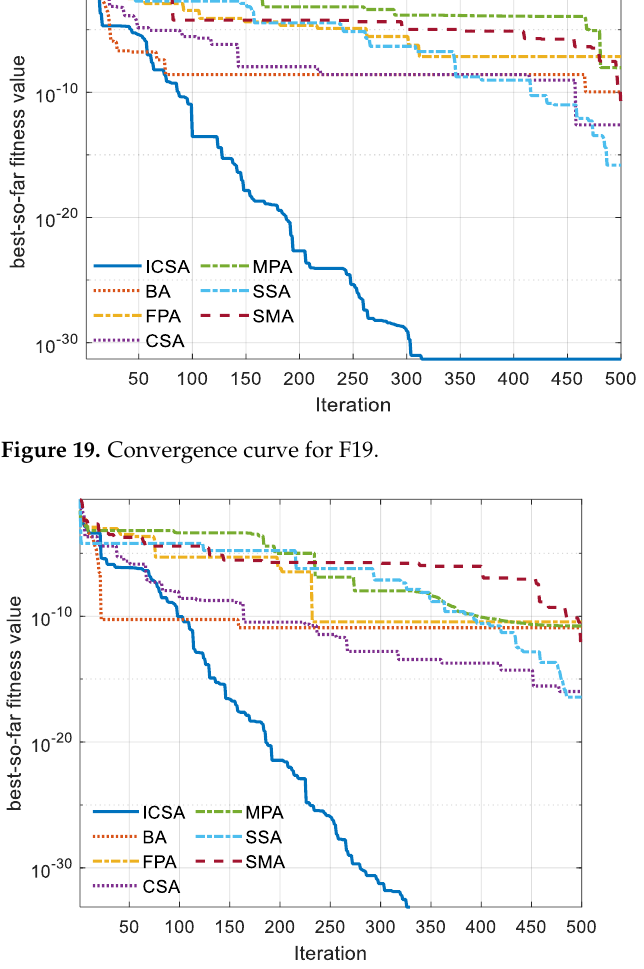
Figure 20. Convergence curve for F20.